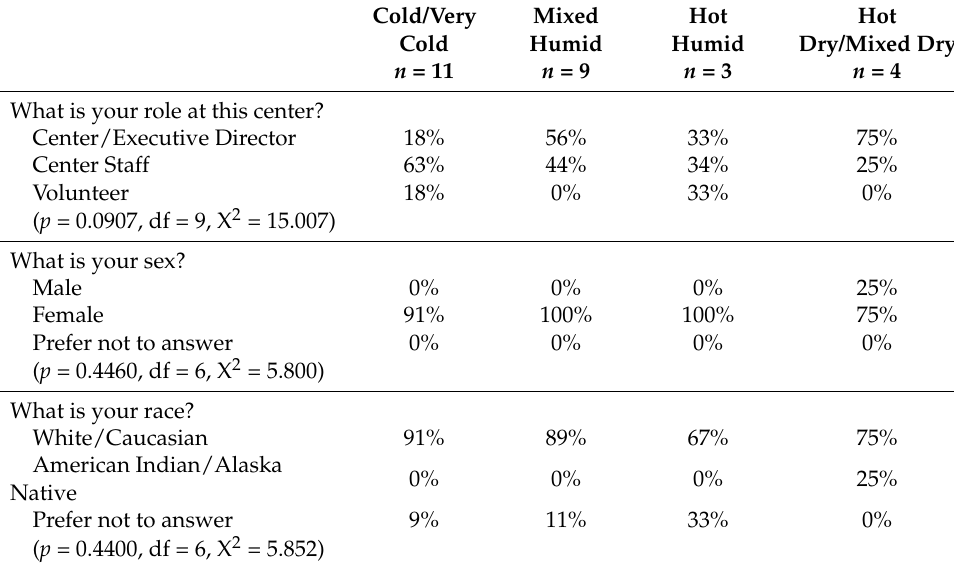
Table 3. Respondent demographics by climate